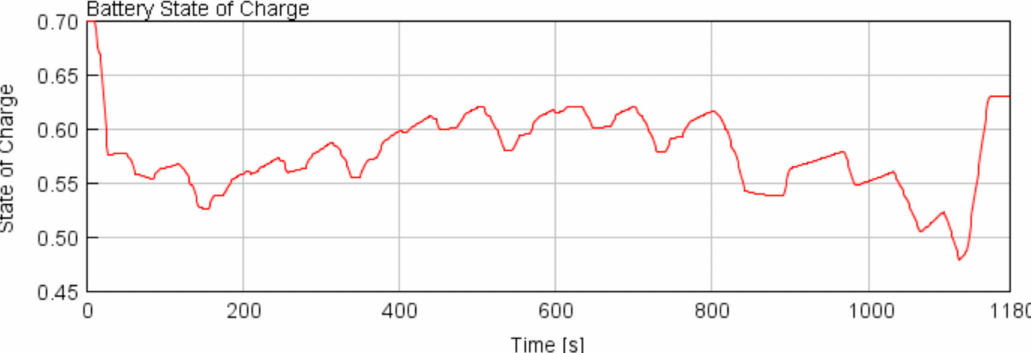
Figure 30. Battery State of Charge in NEDC.